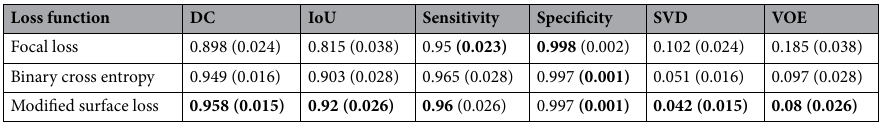
Table 1. Segmentation performance of Res32-PAC-UNet using different loss functions, indicating maximal performance with modified surface loss function. Significant values are in [bold].